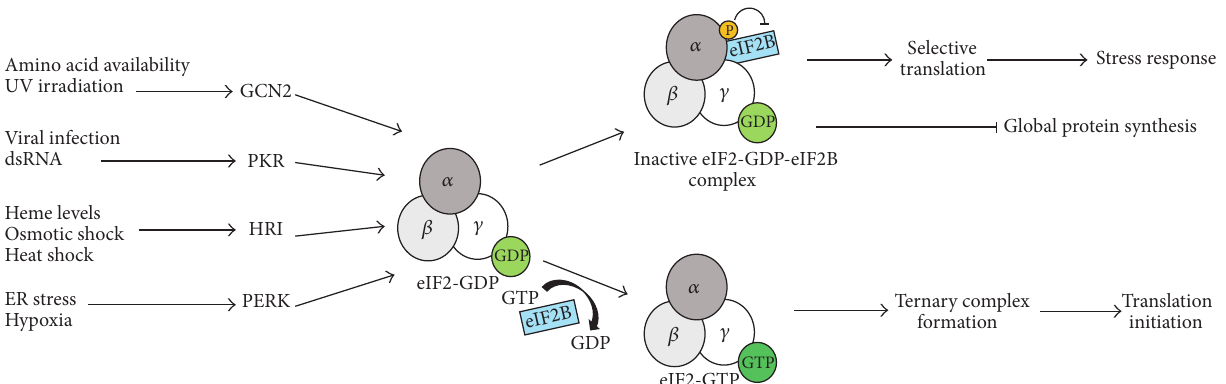
Figure 2: Global translation inhibition by eIF2 𝛼 phosphorylation. Several stress stimuli activate distinct protein kinases, which in turn phosphorylate eIF2 𝛼 . The phosphorylation of eIF2 𝛼 enhances the affinity of eIF2-complex ( 𝛼 , 𝛽 , and 𝛾 subunits) for eIF2B. This renders eIF2-complex inactive for the initiator tRNA delivery to the ribosome. However, a subset of mRNAs harboring cis -elements such as internal ribosome entry site (IRES) or upstream open reading frames (uORFs) are preferentially translated during eIF2 𝛼 phosphorylation conditions. These mechanisms allow production of stress-related proteins. GCN2: general control nonderepressible-2; PKR: protein kinase R; HRI: heme- regulated inhibitor kinase; PERK: PKR-like endoplasmic reticulum kinase.